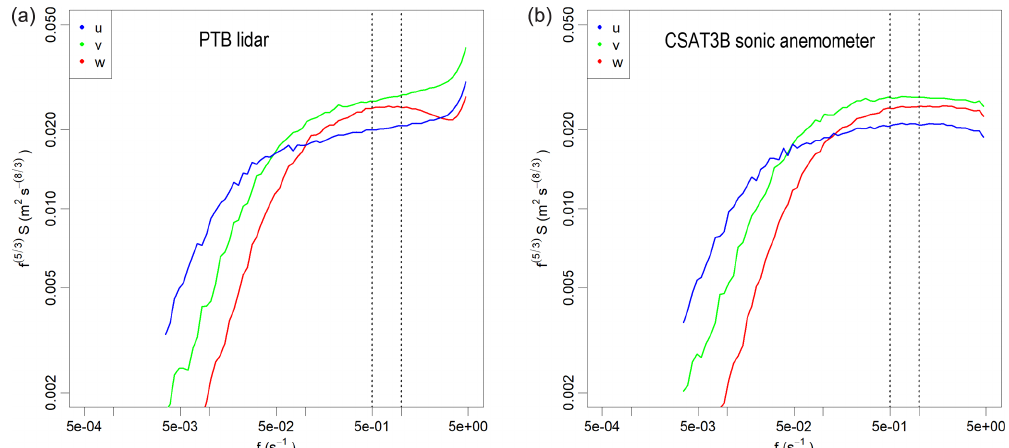
Figure 7. Ensemble turbulence spectra of the three wind components u , v , and w , premultiplied by the frequency f ( 5 / 3 ) , so that the theoretical − 5 / 3 power law appears as a horizontal line. The spectra of the PTB lidar data are shown in (a) and the spectra of the CSAT3B data are shown in (b) . The dashed vertical lines indicate the range between 0.5 and 1s − 1 in the inertial subrange for which the spectral ratios were calculated. Note that the deviations from the expected behaviour in the inertial subrange appear larger than at lower frequencies due to the pre-multiplication.